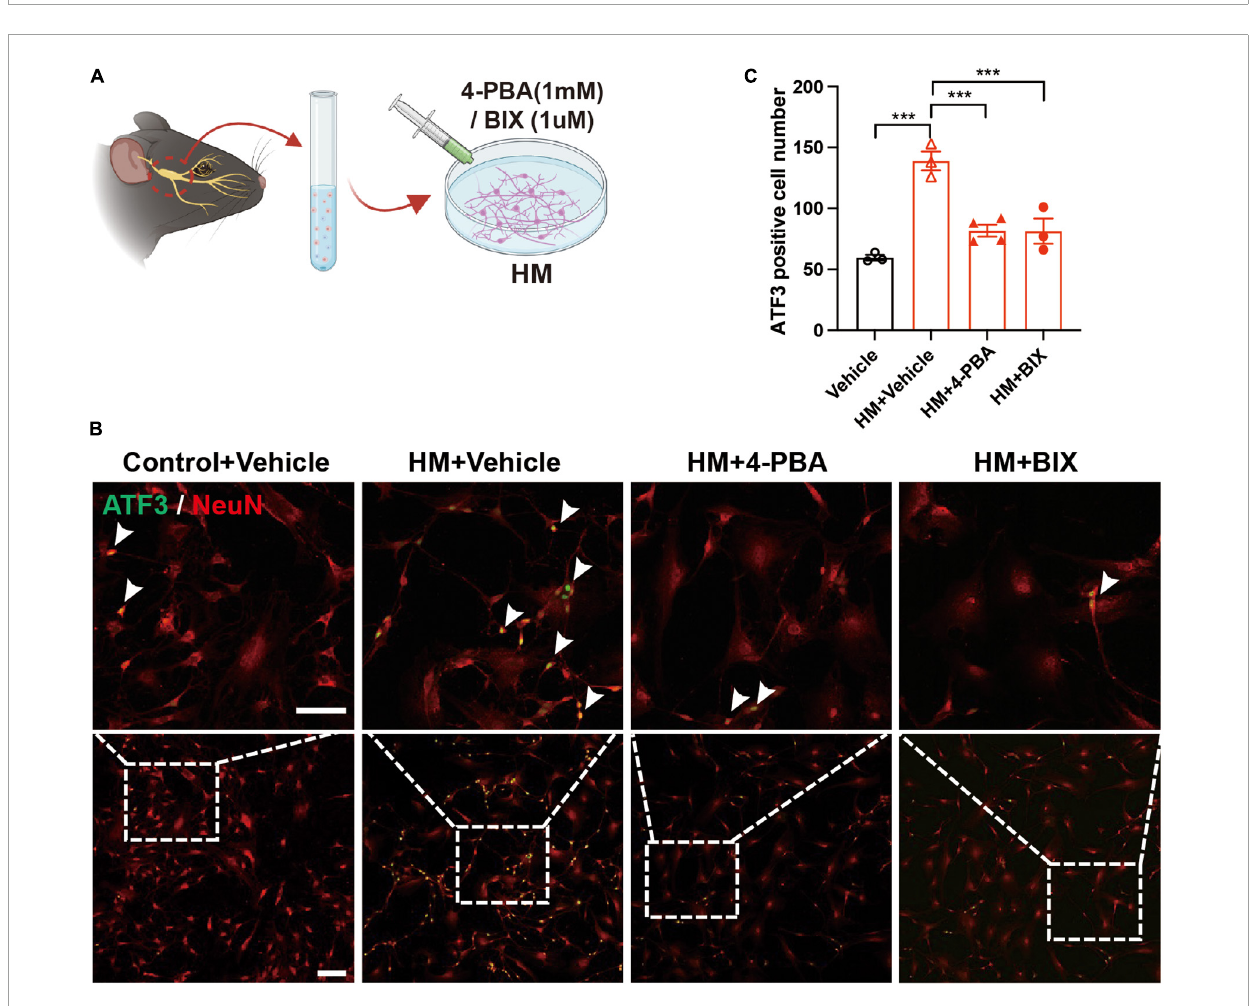
FIGURE6 Decreased TG neuron injury of after inhibiting ERS in hyperosmotic DED. (A) Schematic diagram of the 4-PBA and BIX treatment procedure in vitro . Primary TG neurons were treated with 4-PBA (1 mM) or BIX (1 µ M) in an HM culture. (B) Decreased neuron injury of TG indicated by immunofluorescence staining in HM with ERS inhibitor (4-PBA/BIX) treatment groups. Co-localization of neuron injury marker ATF3 (green, arrowheads) and neuron marker NeuN (red, arrowheads). Scale bars, 100 µ m; (C) Quantification of ATF3-positive neurons in control with vehicle treatment group, HM with vehicle treatment group, HM with 4-PBA treatment group, and HM with BIX treatment group ( n = 3–4 in each group). Y-axis represents the number of ATF3-positive neurons. Each dot represents mean ATF3-positive neurons of three different fields of view (the magnification power of each field is 200) per cell culture dish. Data are represented as mean ± SEM; *** P < 0.001; DED, dry eye disease; ERS, endoplasmic reticulum stress; HM, hyperosmotic medium; TG, trigeminal